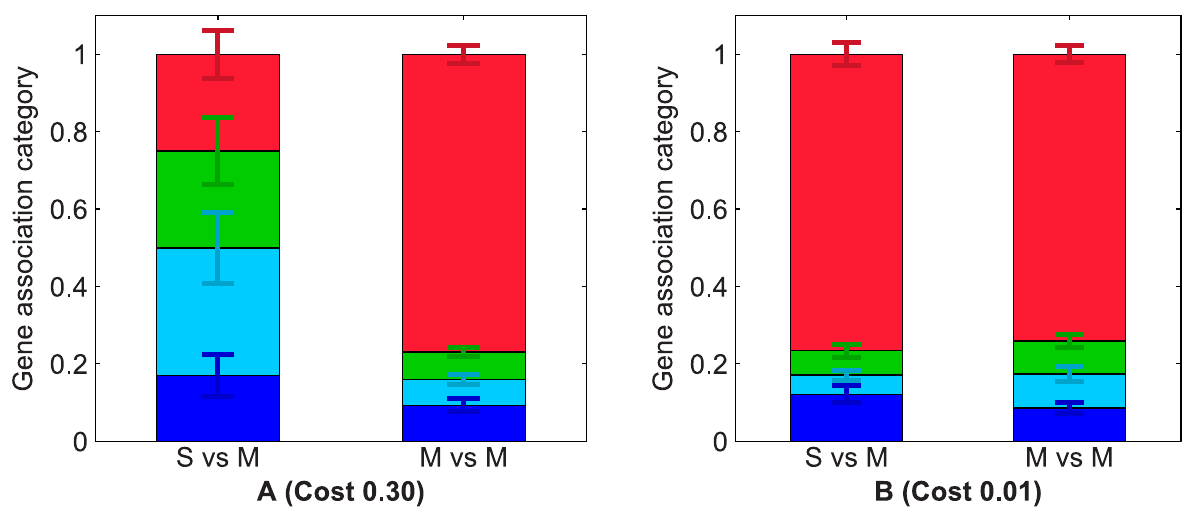
Figure 5. Genetic architecture associations after 20,000 generation of denovo evolution of cooperation, at (A) high, c= 0 : 3 and (B) low, c= 0 : 01 secretion cost. In both cases, we quantified the presence of operons or overlaps between secretion genes and metabolic genes (S vs M) as well as between metabolic genes and other metabolic genes (M vs M). Genes were partitioned in four categories, labeled as in the Fig. 4: sharing a promoter (an operon) without overlapping with a metabolic gene (dark blue), overlapping and sharing an operon with a metabolic gene (light blue), overlapping without sharing an operon with a metabolic gene (green), not sharing an operon nor overlapping with any metabolic gene (red). Error bars represent plus and minus one standard error of the mean for the fifty replicate populations and their color corresponds to the genetic architecture category they relate to.